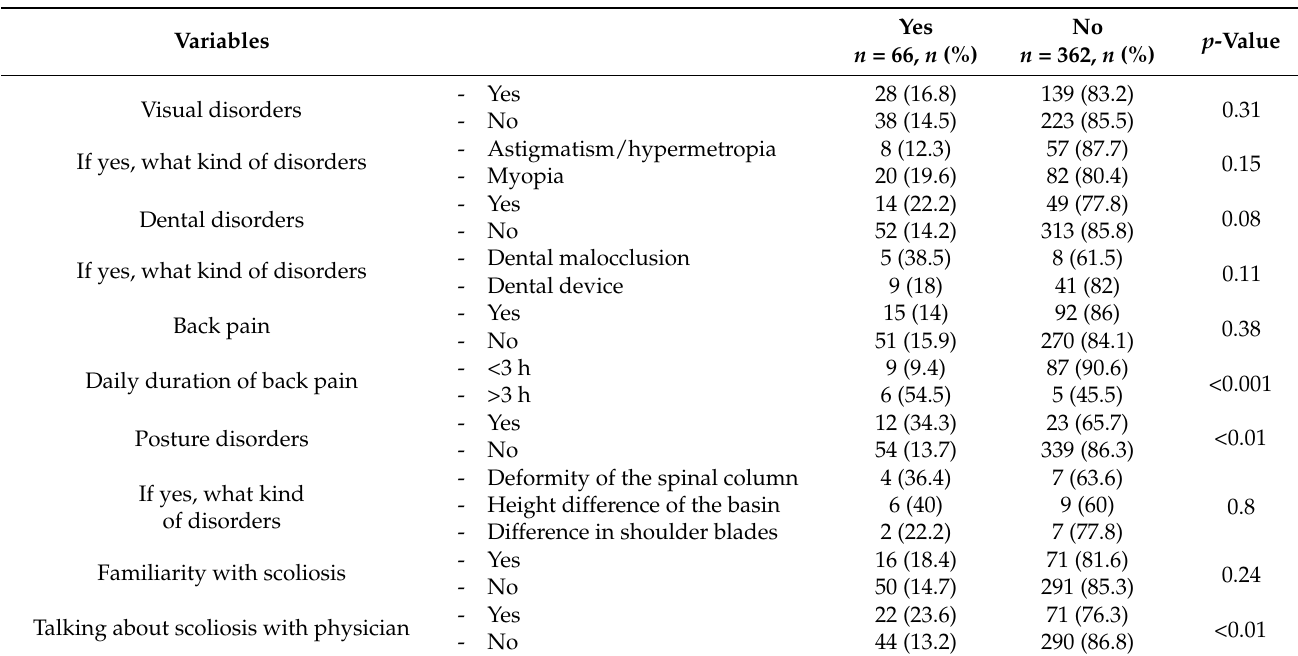
Table 2. Clinical characteristics, attitudes and habits of pre-adolescents enrolled in first-grade secondary schools of the Palermo district of the study sample and association in the univariate analysis to suspected adolescent idiopathic scoliosis ( n =